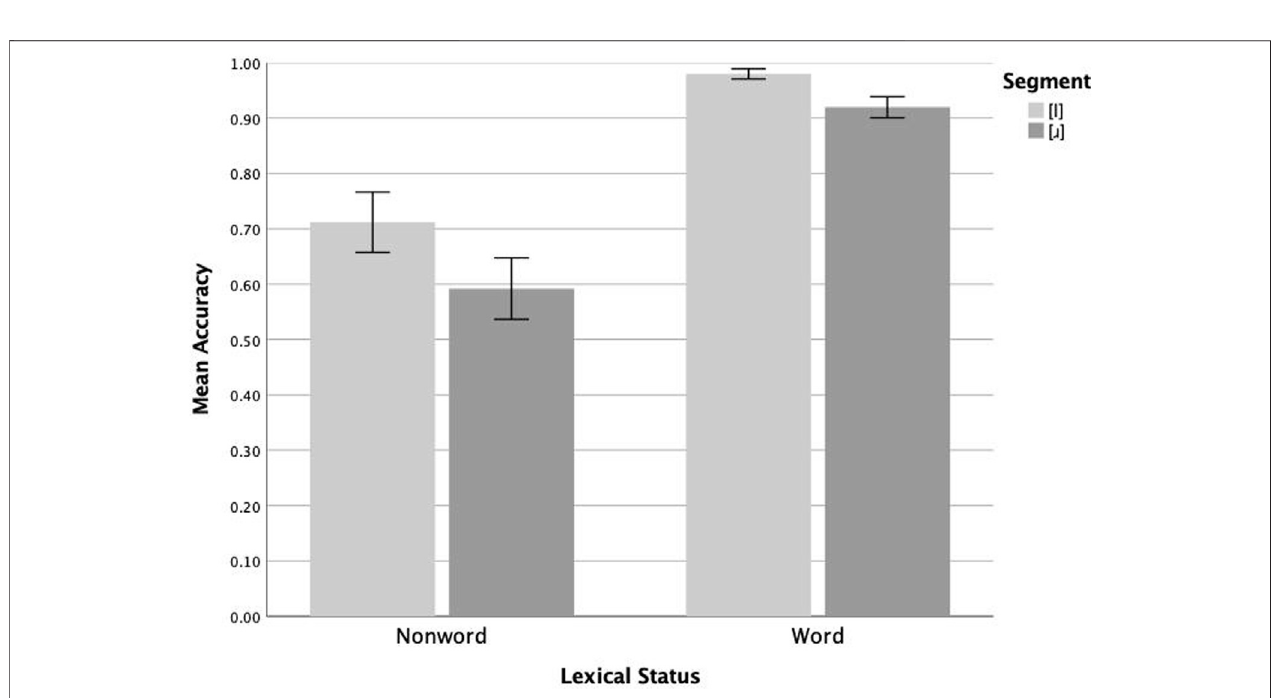
FIGURE 4 | Mean lexical accuracy (proportion correct) on [l] and [ ɹ ] items by native Mandarin speakers ( n (cid:1) 18). Whiskers represent 1 SE.